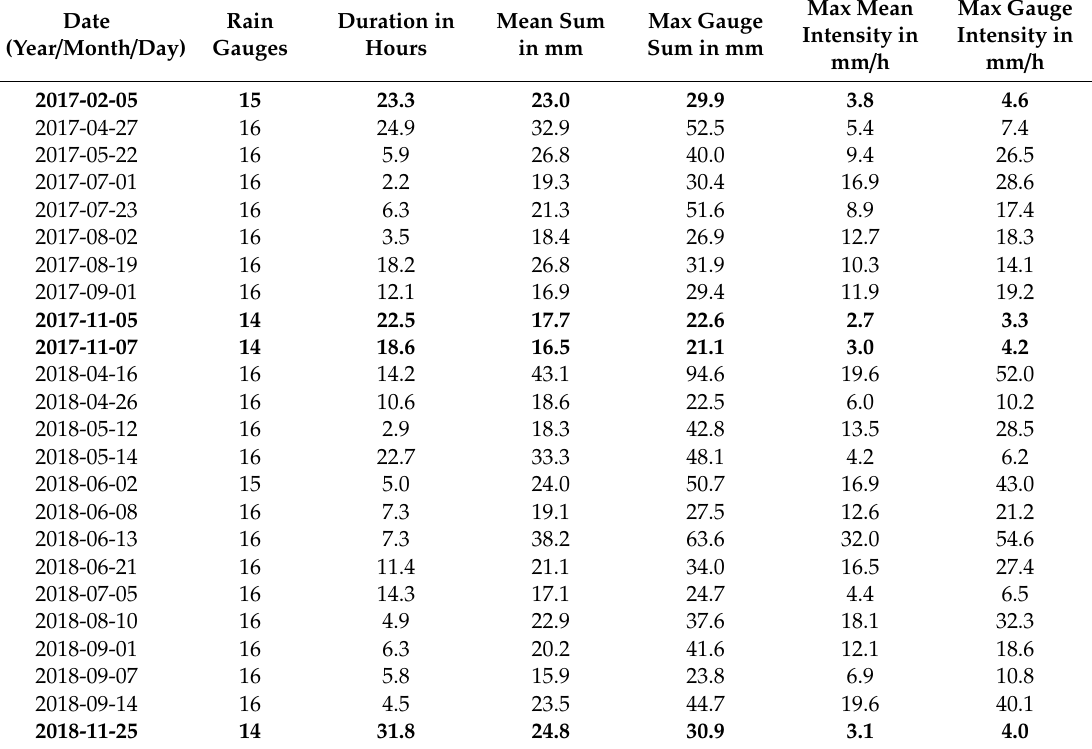
Table 4. Summary of the 24 events chosen for analysis with the arithmetic mean of all active rain gauges and the maximums of individual gauges per event. Bold events are in the group “cold